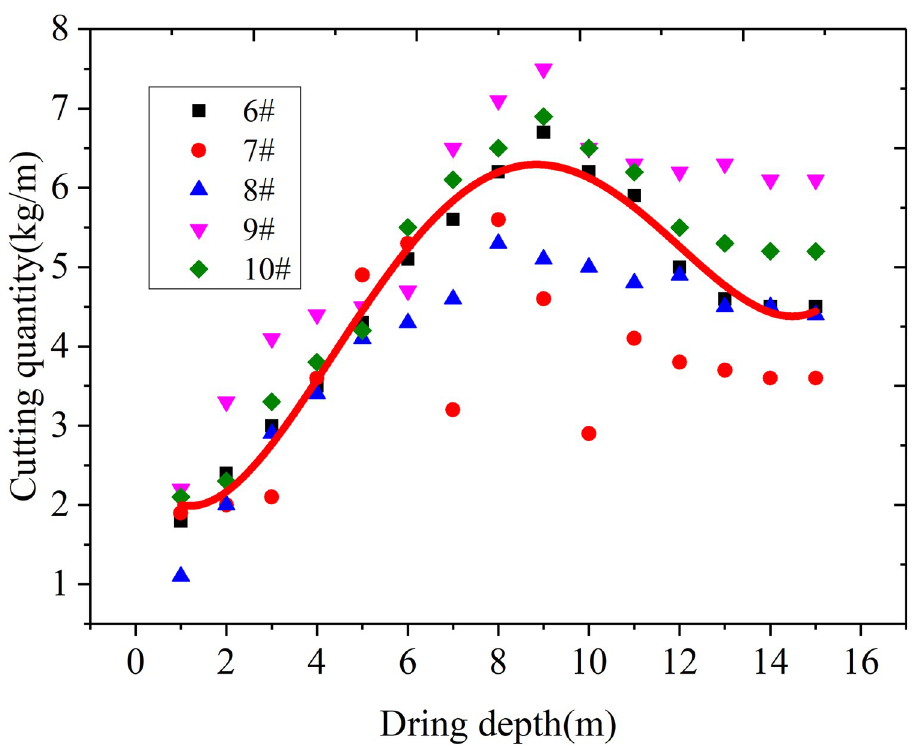
Fig 15. Relationship between the drilling depth and the cuttings quantity at the 10 selected sampling sites of the 23302 working face 6–10#.